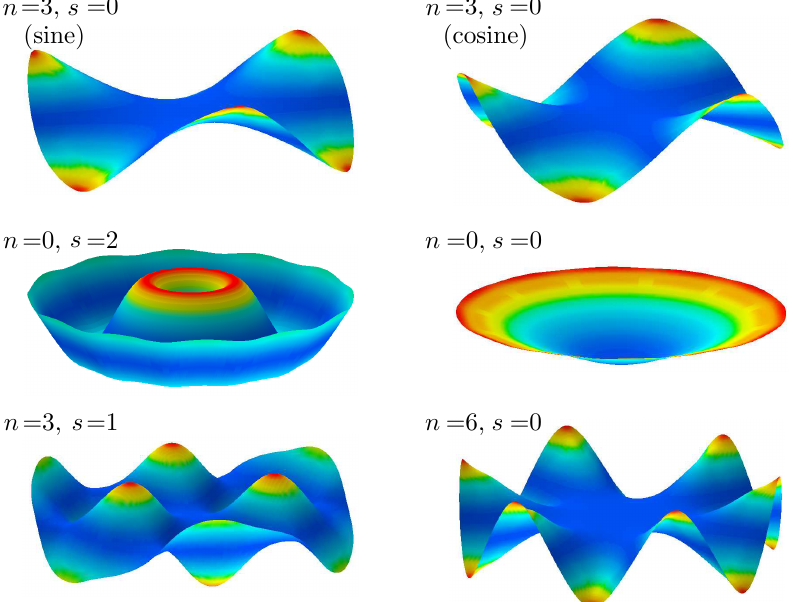
Figure 7. Mode shapes of the disk equipped with 12 PZT patches and 16 small magnets. The modes are almost harmonic and very close to those of a perfectly axisymmetric